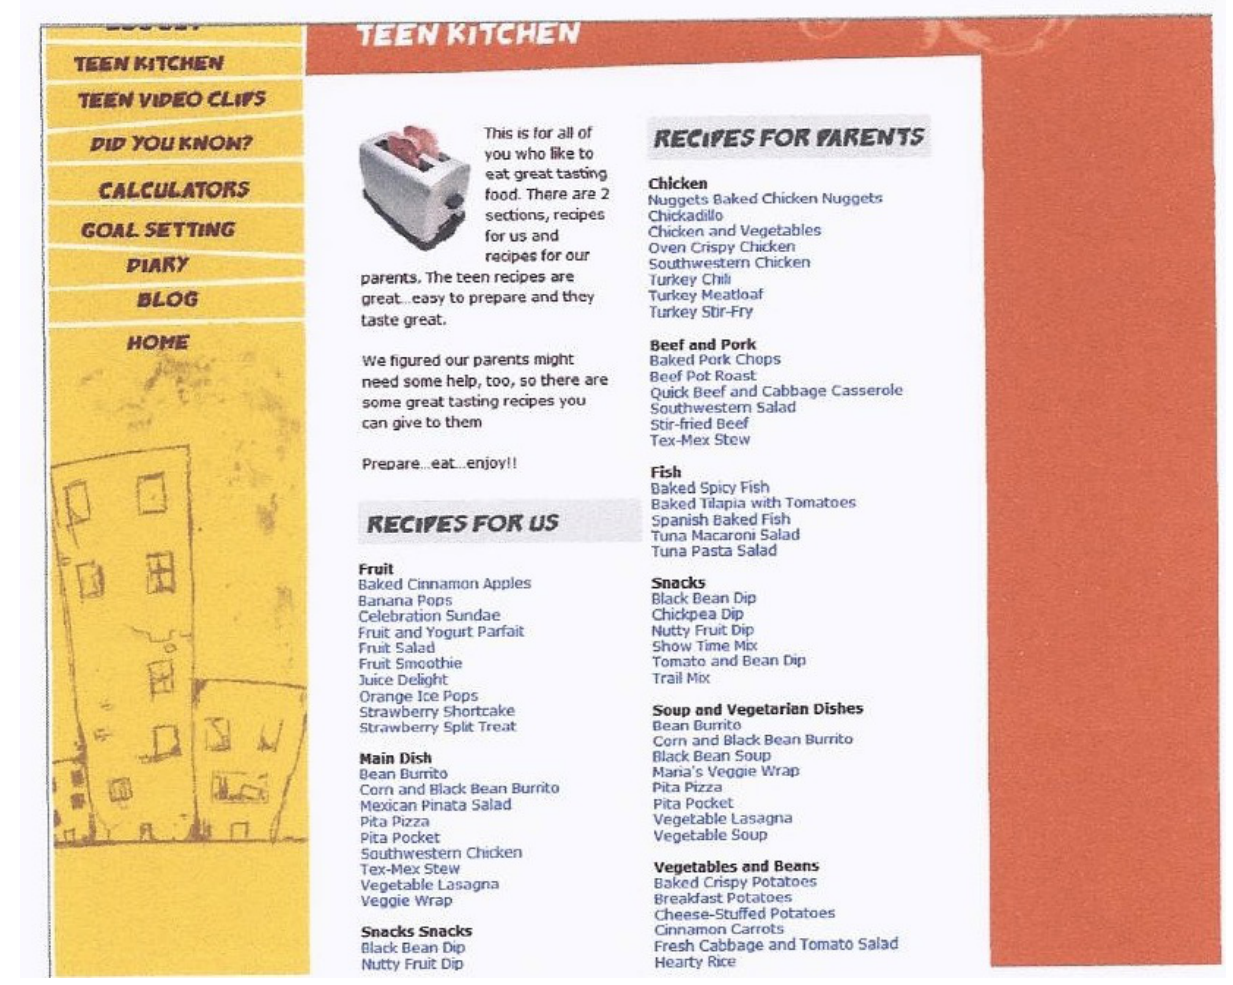
Figure 3. “Teen Kitchen” screenshot showing teen and parent